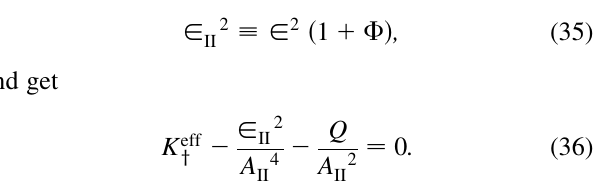
Table II. First-, second-, and third-order results for A , from (34), (36), and (37), are plotted in Fig. 1(a) for FODO. The